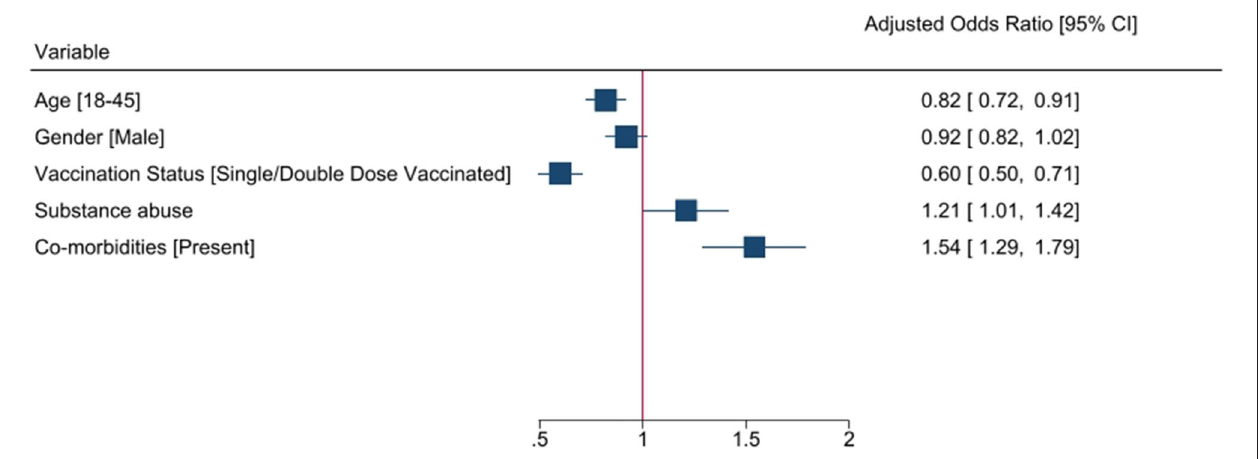
FIGURE 2 | Association of baseline characteristics with clinical recovery at day